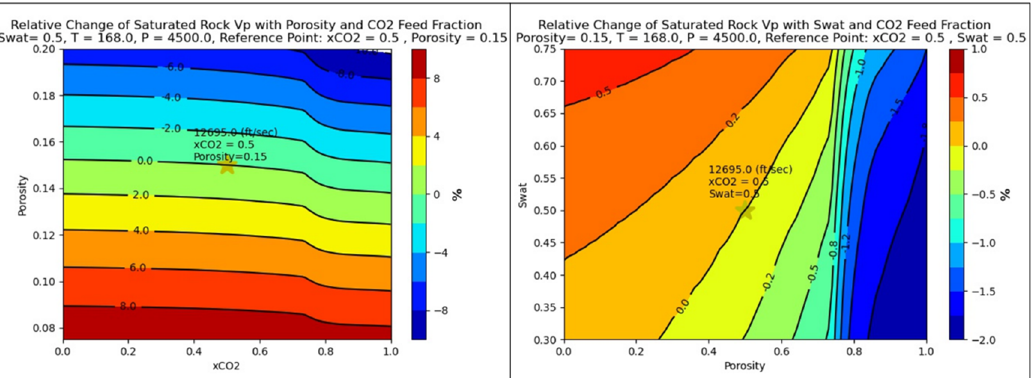
Figure 17. Contoured variations of saturated rock P velocity vs. CO 2 mole fraction and porosity ( left ), and water saturation ( right ) at reservoir conditions T = 168 °F, and p = 4500 psi, xCO 2 = 0.5. Contours are percent change relative to reference points shown.